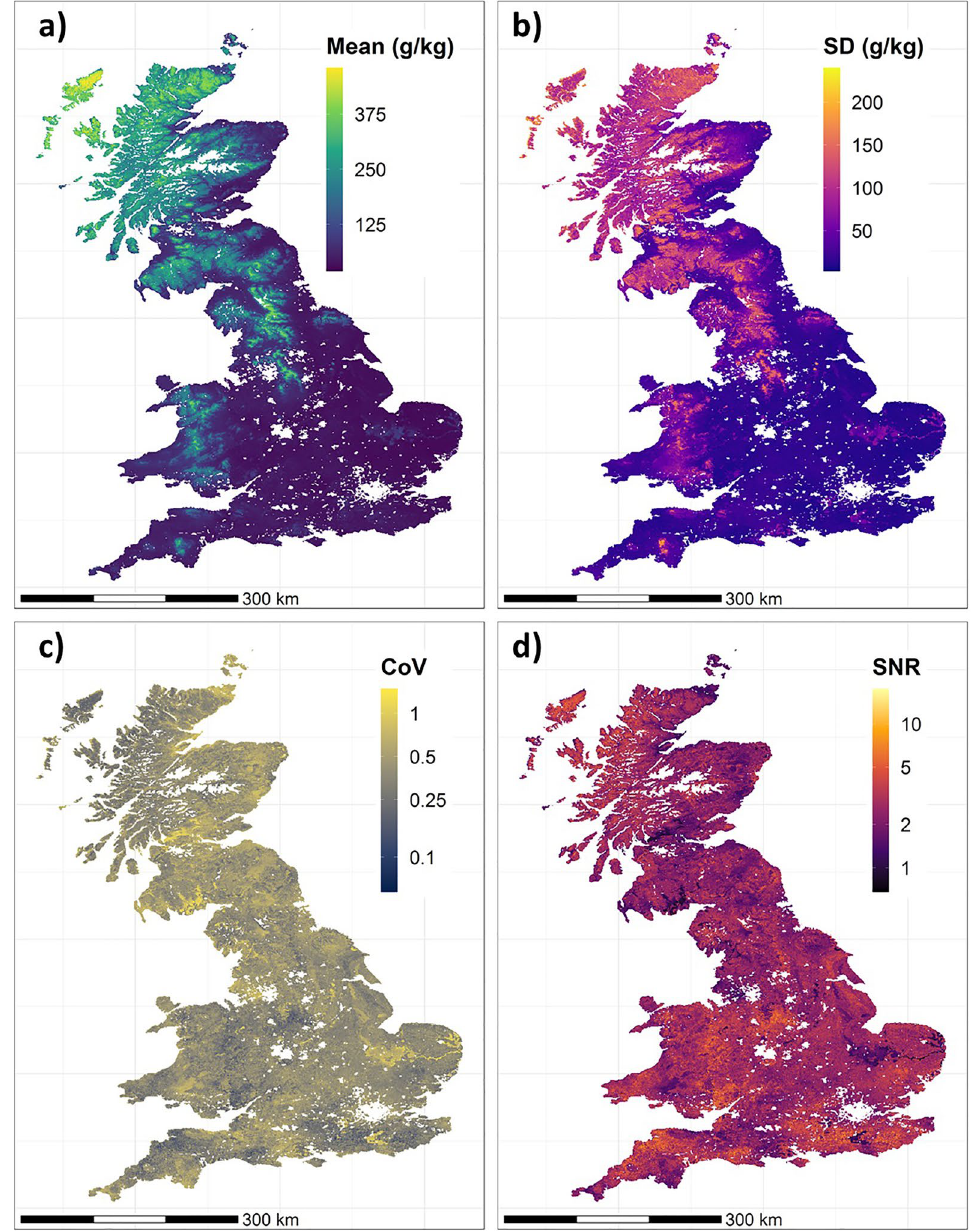
Figure 1. Maps of the ( a ) mean topsoil SOC concentrations of all eight maps; ( b ) standard deviations of the mean (SD); ( c ) coefficient of variation values (standard deviation/mean); and ( d ) the signal to noise ratios (the reciprocal of the coefficient of variation i.e. mean/standard deviation). Note here that statistics were calculated after each of the 8 maps were modified to harmonise them to a common spatial extent, resolution and units of SOC concentration. Values are calculated only for those 1 km grid cells that contain data from all the topsoil SOC concentration maps. White areas indicate where there are no data for at least one of the maps, including urban areas and littoral broad habitats with little topsoil and parts of Scotland (excluded from CSGB-AIC due to the low spatial representation of CS 2007 points in montane broad